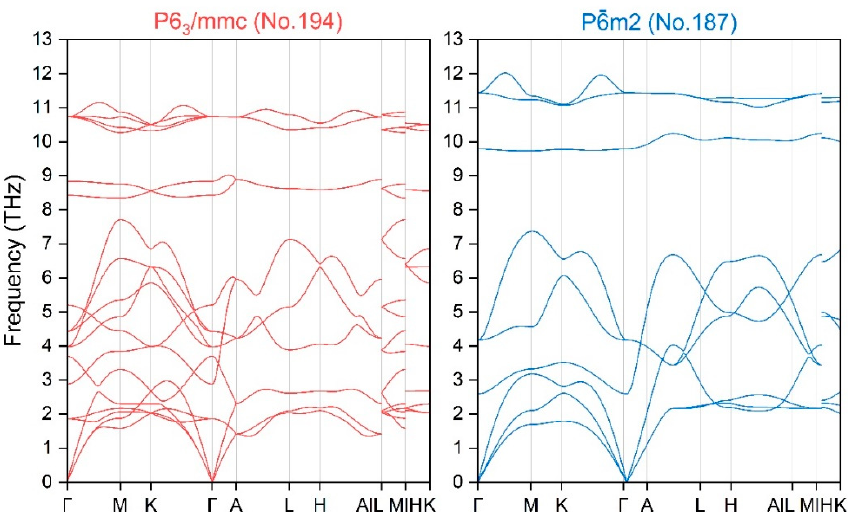
Figure A2. The phono band spectra for BaLiP materials under the two different crystal structures. The corresponding crystal space groups are located on the top with different colors. To further examine the phononic mode and vibrate direction of the studied two topological bands, we have decomposed the bands with element contribution and vibration, and their results are reported Figures A3 and A4, respective. From Figure A3, we found the entire phonon band can be divided into three parts from the frequency range: low frequency bands from Ba element, middle frequency bands from P element and high frequency bands from Li element. Especially, the two bands between 8.2 THz and 9.2 THz are only contributed by the Li element.